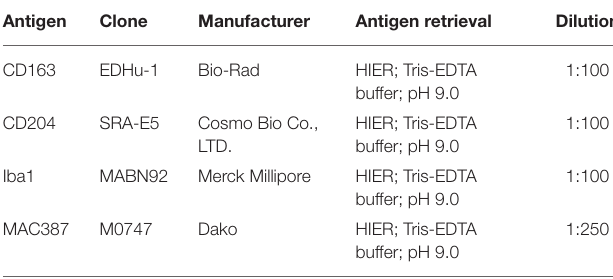
TABLE 1 | Protocol details for